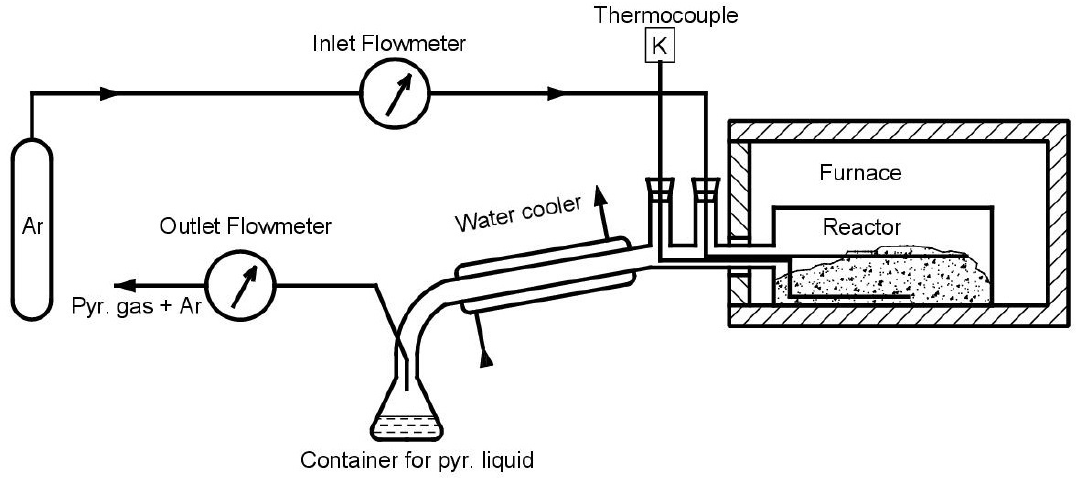
Figure 2. Scheme of laboratory pyrolysis unit.